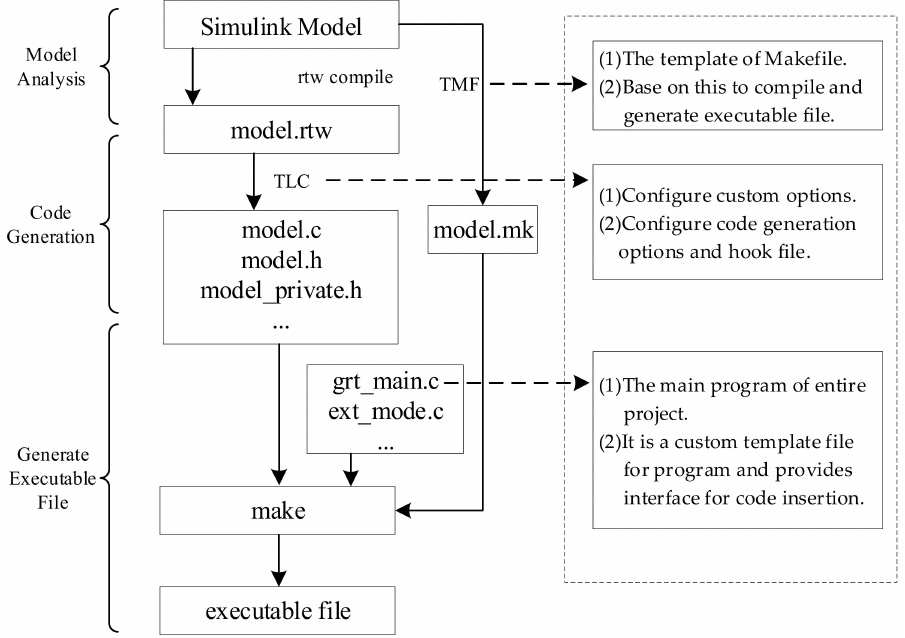
Figure 2. Automatic code generation